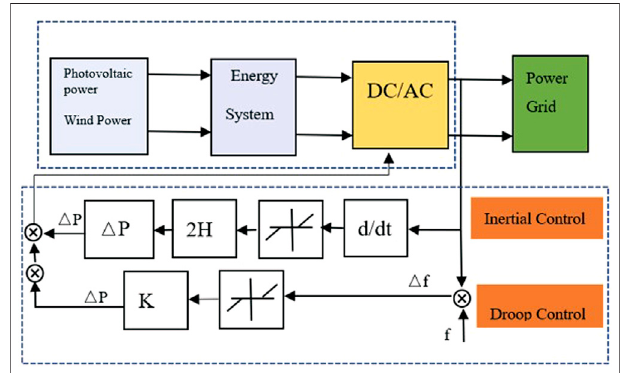
FIGURE 2 | Structure of the integrated energy